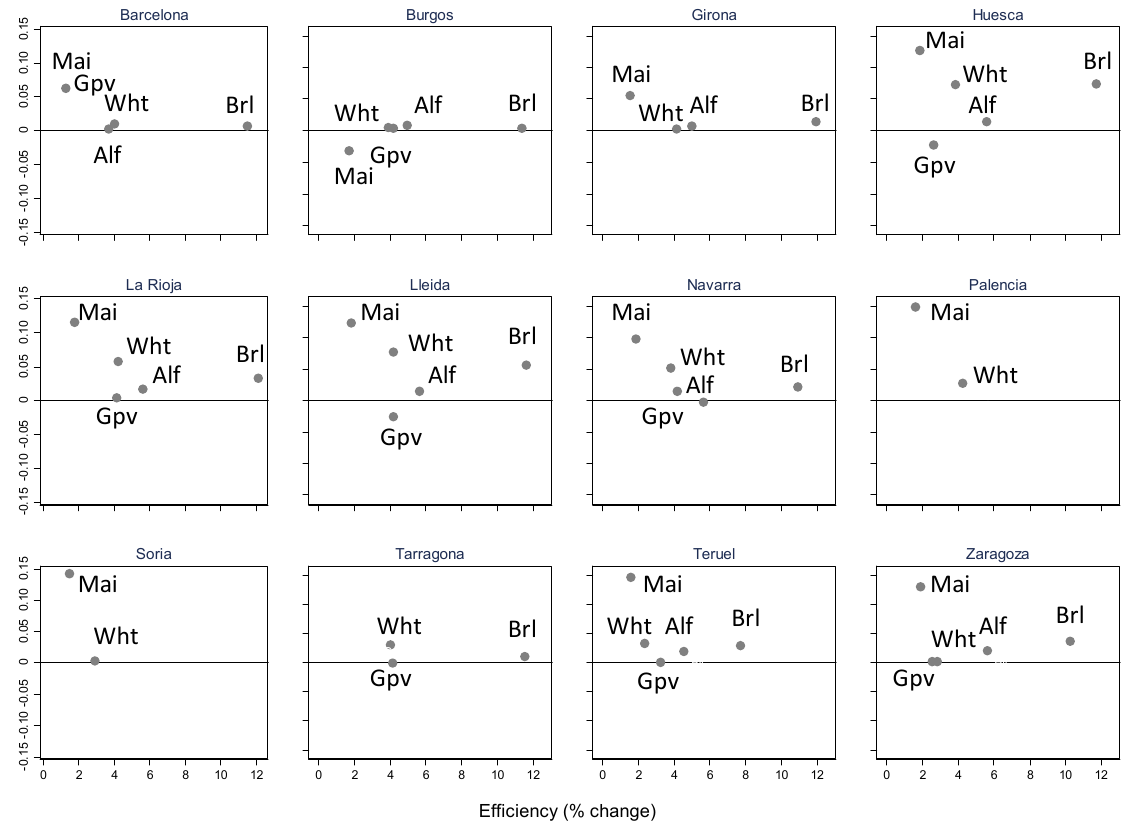
Figure 5. Marginal effects of the irrigated area on competitiveness (efficiency) and income distribution (equity) by region in % change.